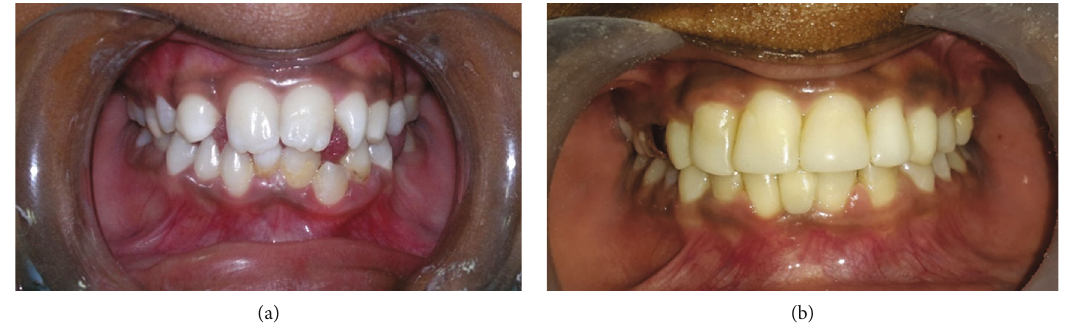
Figure 13: Comparison of preoperative and postoperative aesthetic